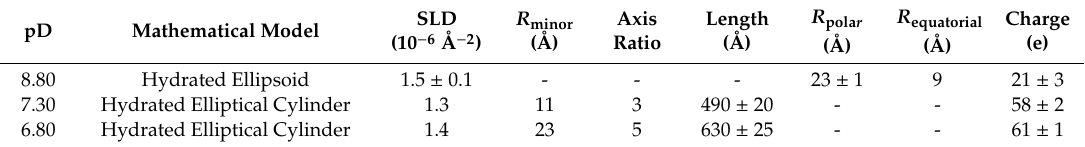
Table 1. Comparison between hydrated ellipsoid and the hydrated elliptical cylinder models for 5 mg mL − 1 NaDC: pD-dependence of scattering length density (SLD), polar and equatorial radii and charge. All values have a standard deviation lower than 1%, except where indicated otherwise.